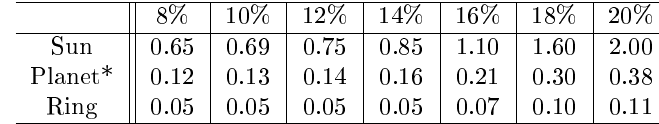
Table 8: Total fatigue damage as a function of increas- ing